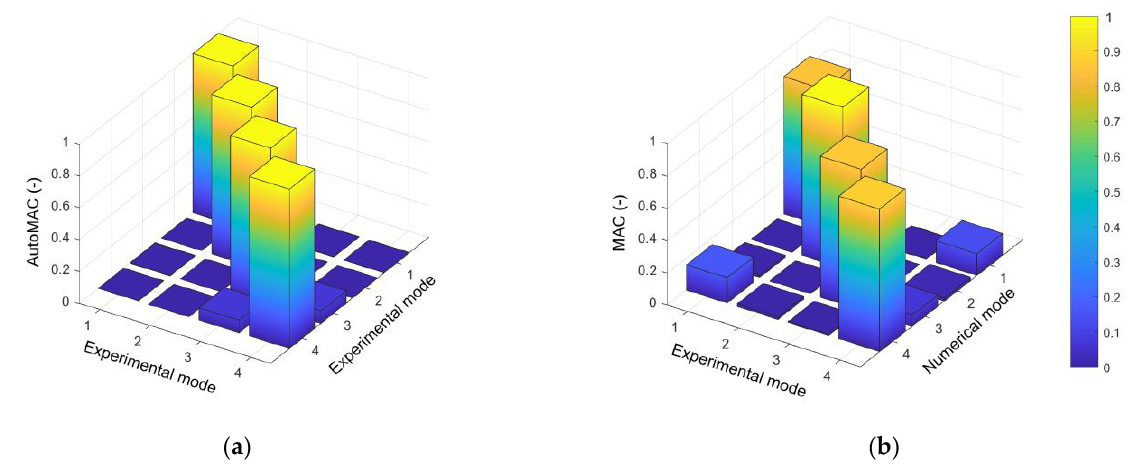
Figure 16. ( a ) The AutoMAC diagram for experimental modes, ( b ) the modal assurance criterion (MAC) diagram for experimentally and numerically determined modes.